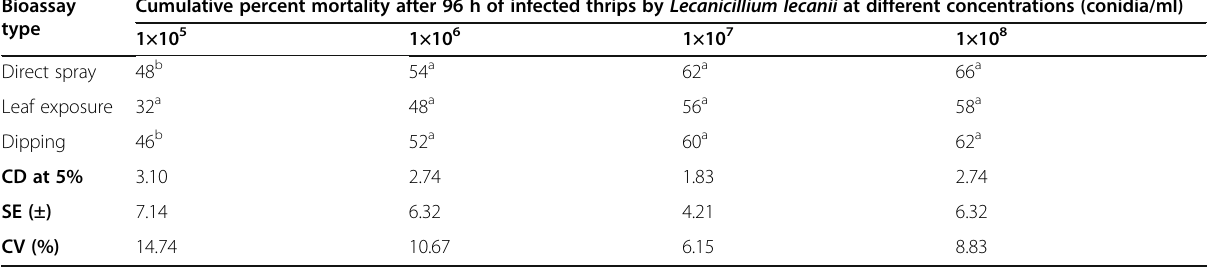
Table 2 Different laboratory bioassays adopted against tea thrips nymphs Bioassay type